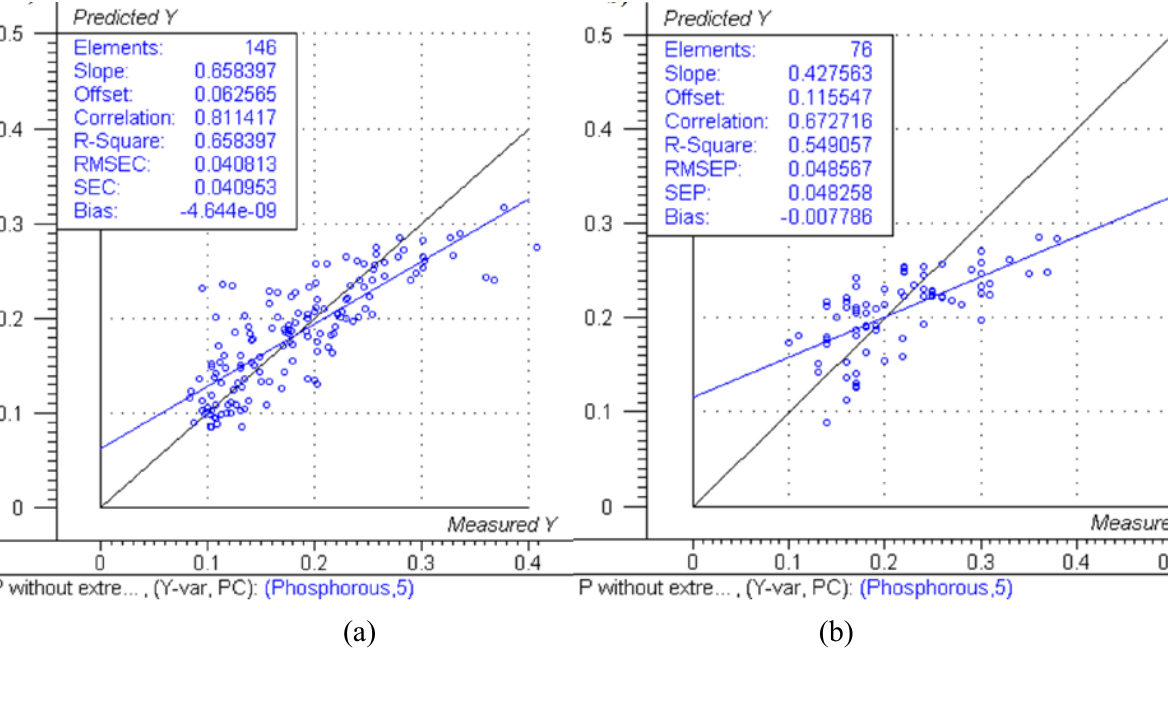
Figure 2. Predicted vs. reference plots and model data for: (a) Phosphorous calibration. ( b ) Phosphorous validation. The black lines represent the ideal 1:1 relationship between reference and predicted measurements, the blue lines represent the actual regression lines calculated in each calibration or